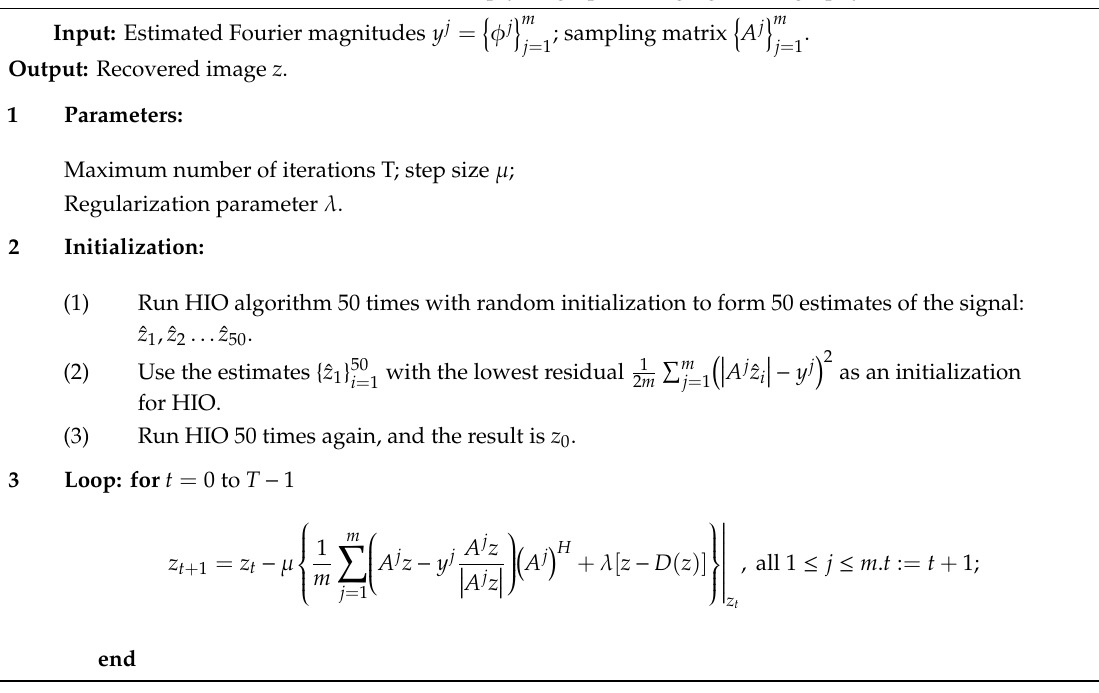
Algorithm 1: The reconstruction framework for ptychographic imaging